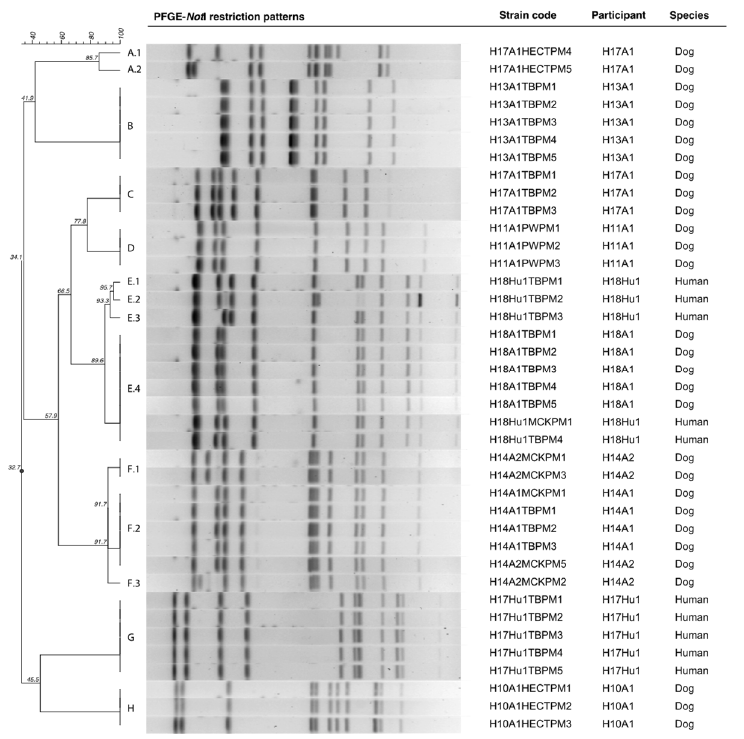
Figure 2. PFGE analysis of P. mirabilis colonizing the gut of humans and dogs.